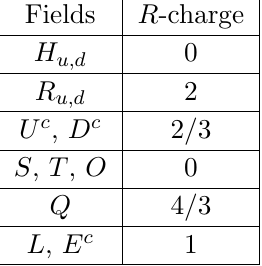
Table 1. R -charge assignment of chiral super(cid:12)elds of the